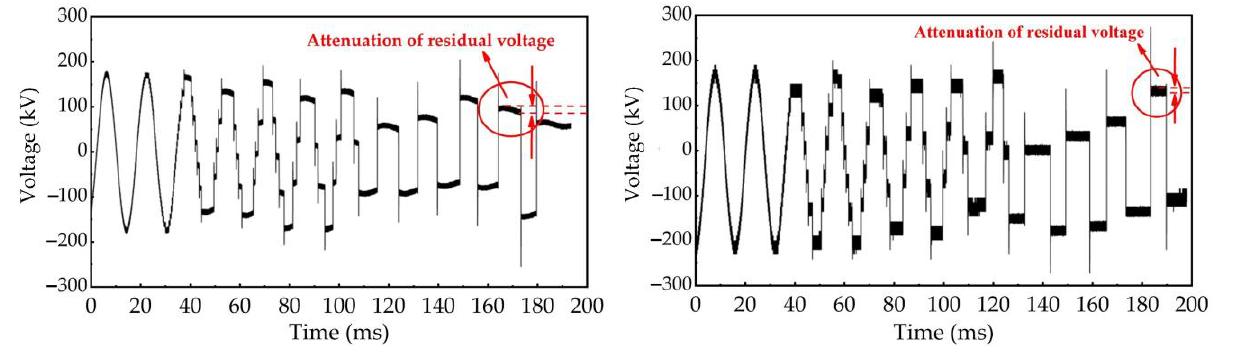
Figure 12. The typical full-time waveform of VFTO measured by the new signal conditioning sensor and the old impedance converter during opening operation.